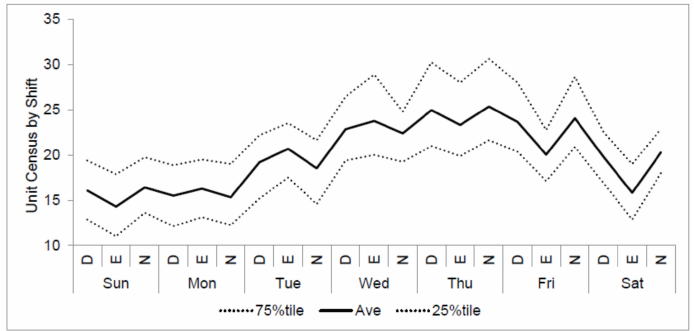
Figure 7. Start-of-shift census fluctuations in a single unit—weekly cycle. D = day shift, E = evening shift, and N = night shift.